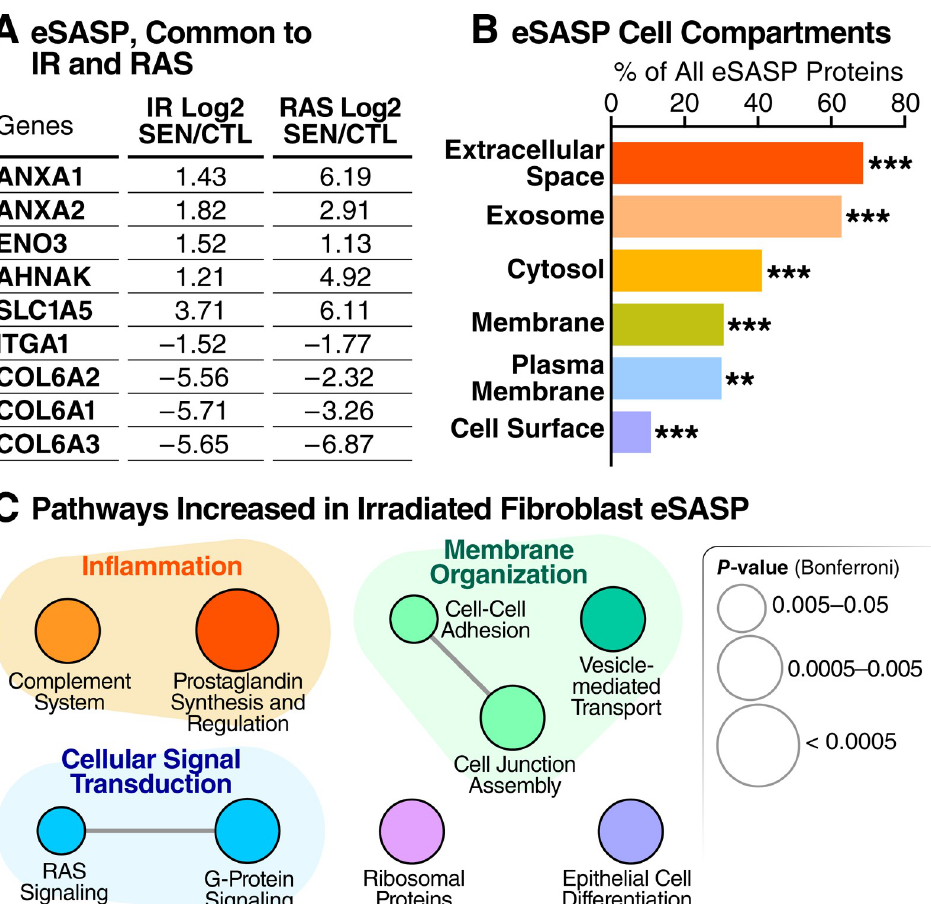
Fig 5. Cellular senescence alters exosome/EV features and composition. (A) Table showing overlapping significant protein changes in exosomes/EVs secreted by senescent cells induced by IR versus RAS (q < 0.05). (B) Enrichment analysis of gene-ontology/cellular compartments overrepresented among protein contents of exosomes/EVs released by senescent cells. (C) Network analysis of pathways and functions unique to the eSASP. CTL, quiescent control; eSASP, extracellular vesicle senescence-associated secretory phenotype; EV, extracellular vesicle; IR, X-irradiation; RAS, inducible RAS overexpression; SEN, senescent.